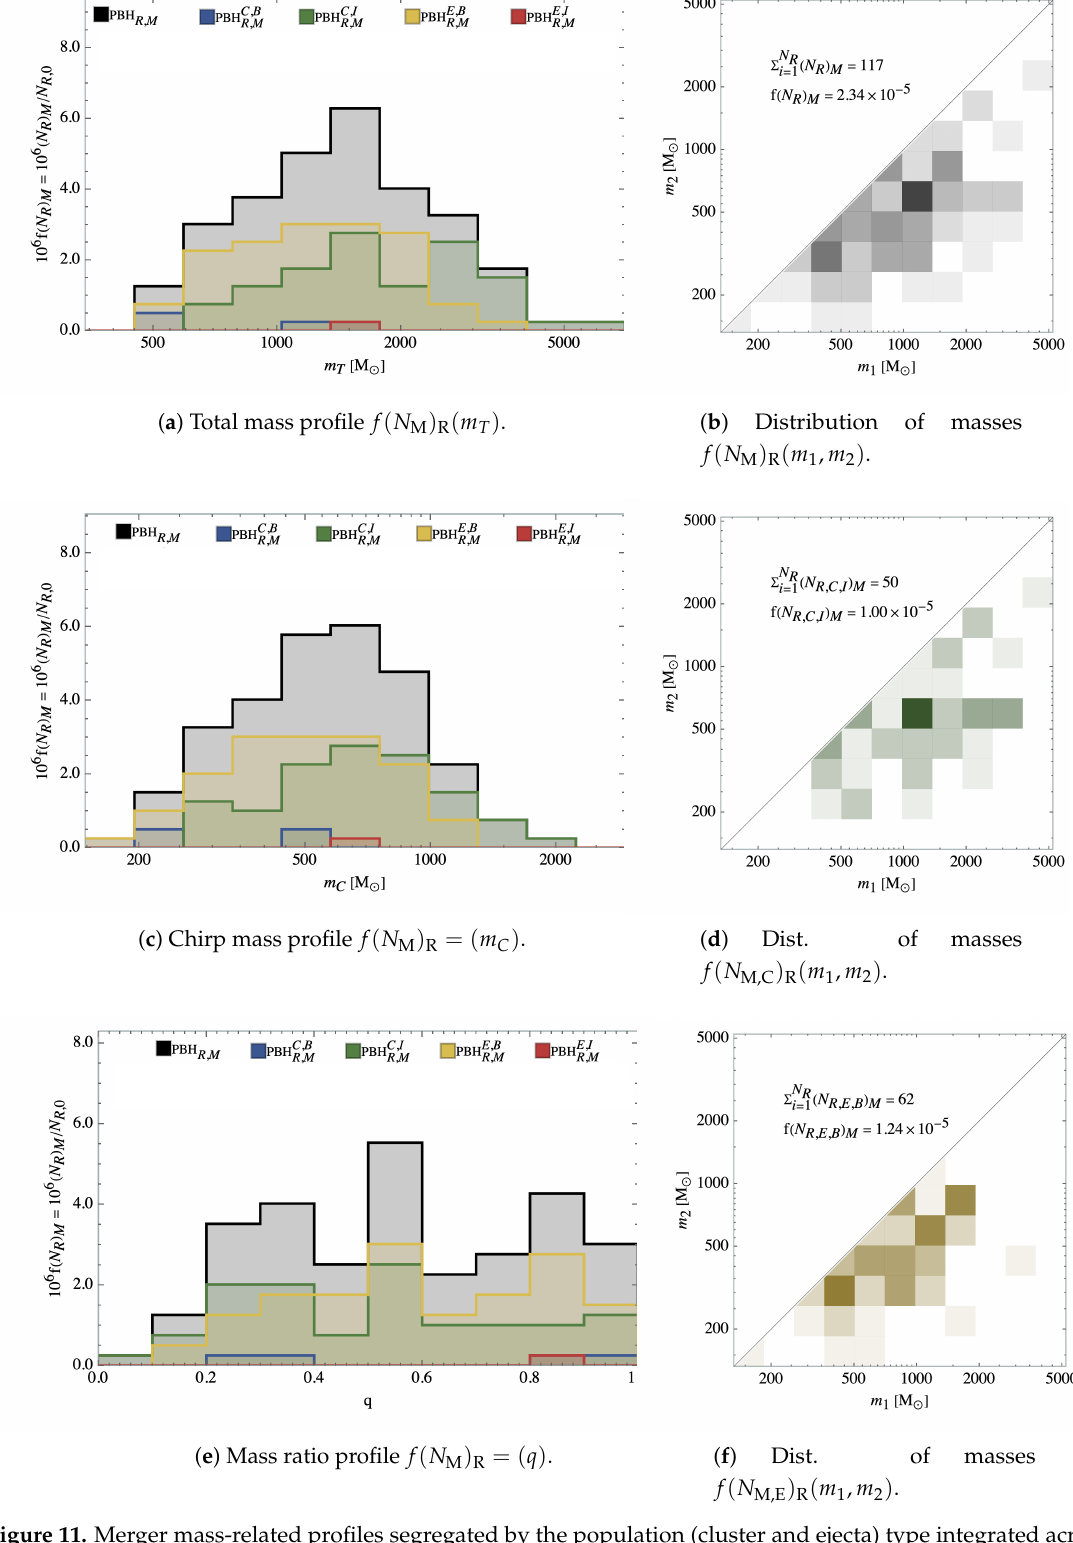
Figure 11. Merger mass-related profiles segregated by the population (cluster and ejecta) type integrated across all time slices in the simulations staring at the time of first-merger t FM = 1.38 × 10 9 yr up to the present. Profiles are normalised by the total number of objects in the simulations at the initial time, N t , and distribution mean and median values are given in 0 Table 11. Note that panels ( b , d , f ) are arranged again as in Figure 10 by choosing m 1 > m 2 to avoid double-plotting and so again all binary systems are represented by a single point at or below the first quadrant